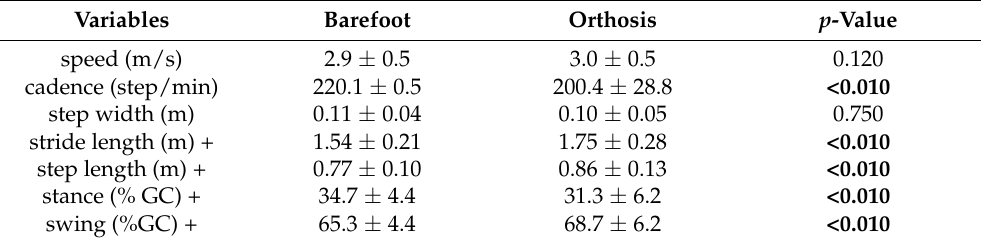
swing (%GC) + 65.3 ± 4.4 68.7 ± 6.2